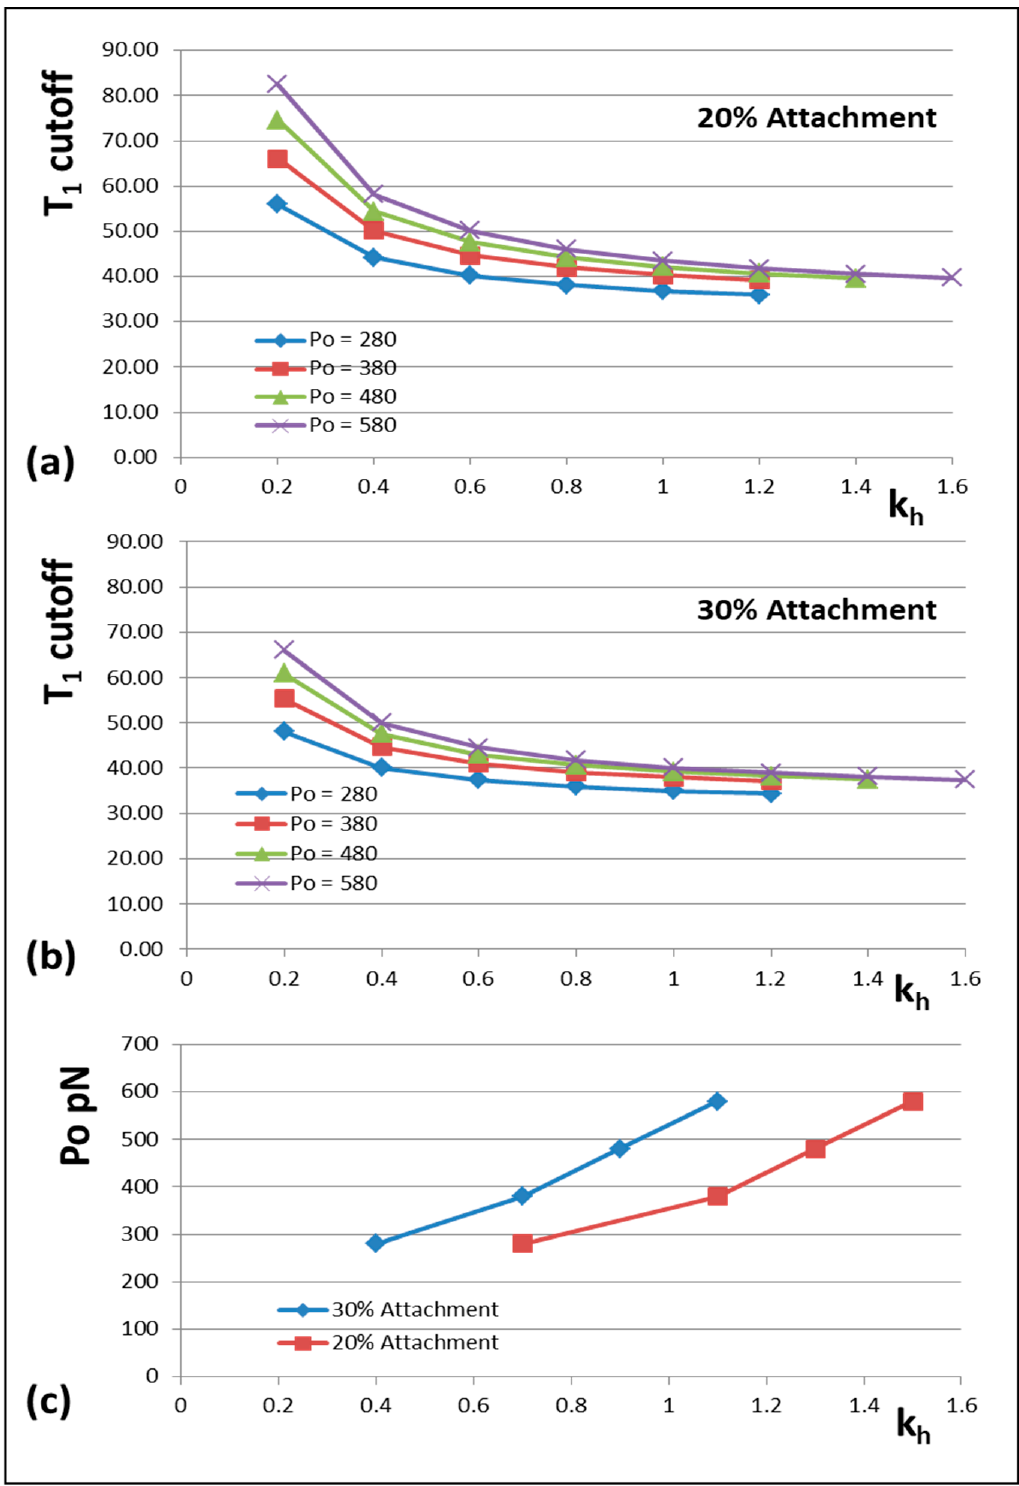
Figure 7. The variation of the T 1 intercept at zero force plotted against head stiffness ( k h ) for different percentages of heads attached to actin ( a ) 20% and ( b ) 30% and at different P o values (pN). ( c ) A plot of P o against k h for a T 1 cut-o ff at 40 Å and di ff erent percentage attachments. Throughout, it is assumed that the changes in X-ray spacings shown in Figure 1 d